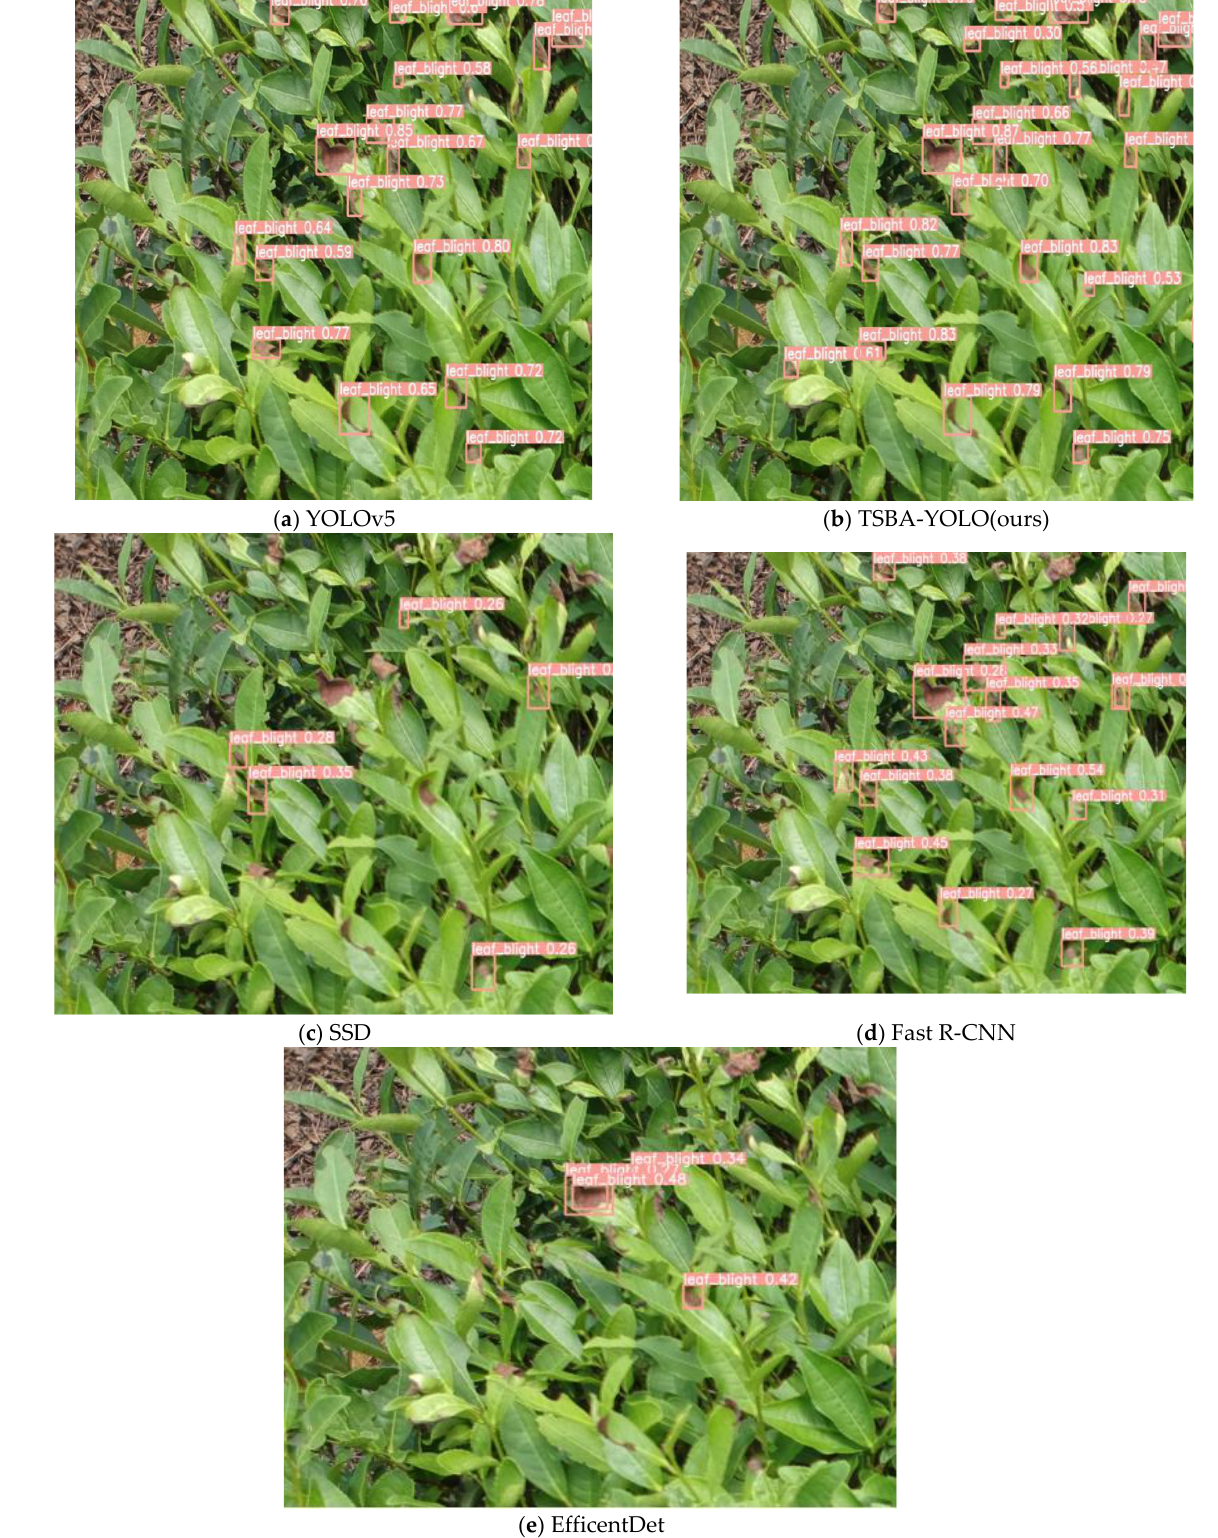
Figure 18. Comparison of different models for detecting small target tea diseases. ( a–e ) are the detection results of the different